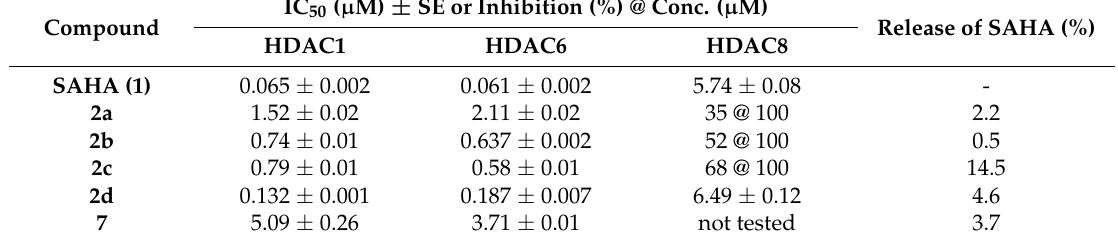
Table 1. In vitro test results of SAHA and the carbamates against the HDAC subtypes 1, 6 and 8. The table also contains the results of the stability tests under in vitro assay conditions (right column).